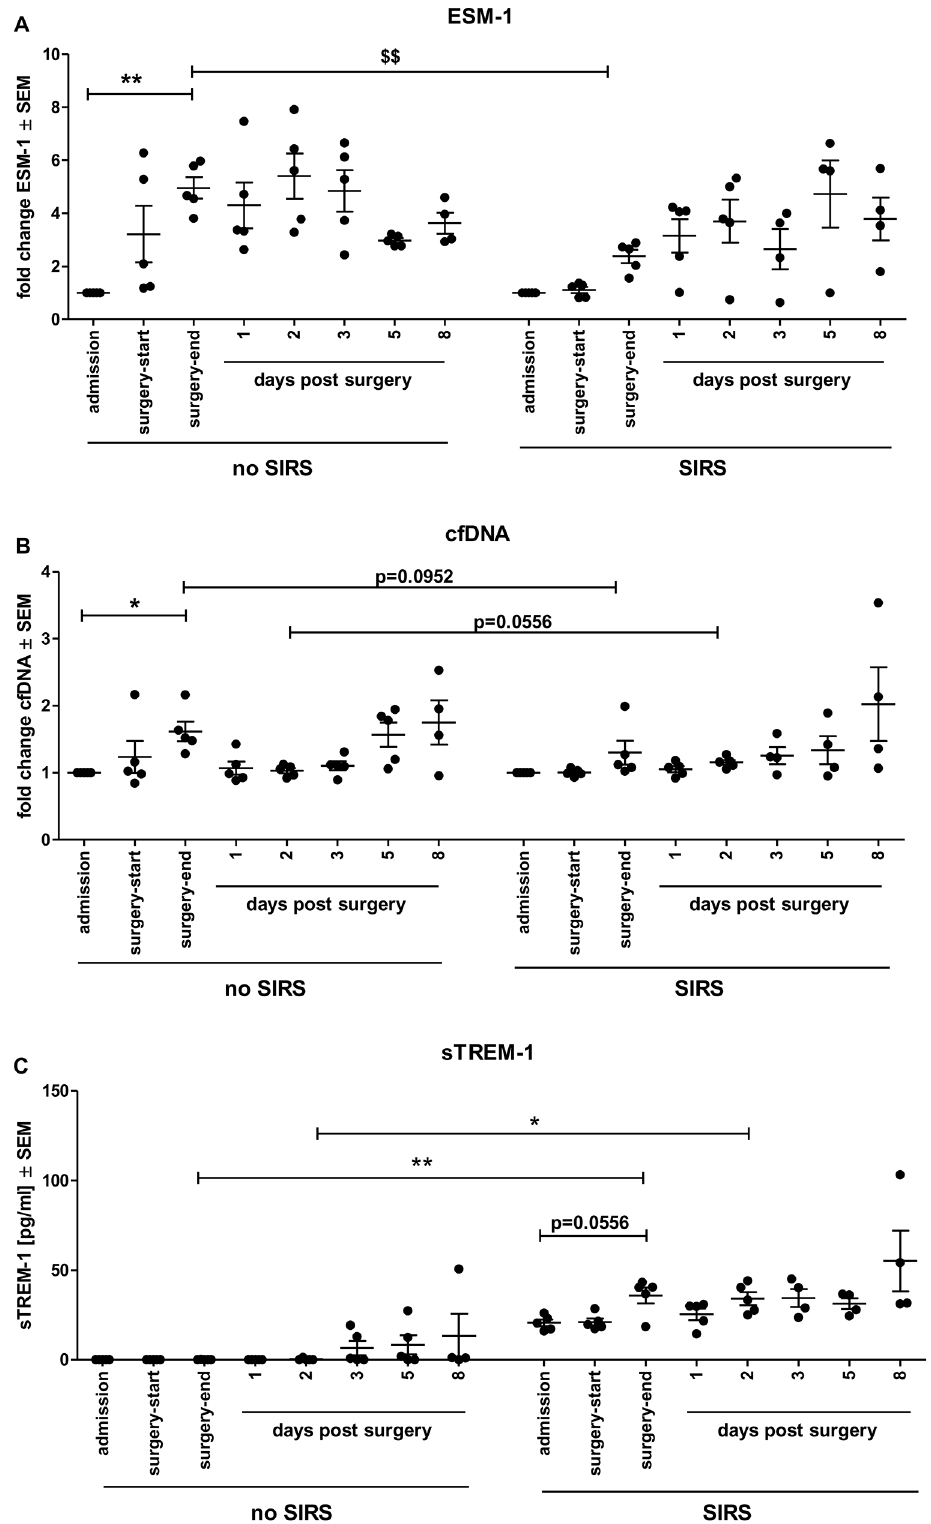
Fig 3. Normalized plasma levels of endocan and cfDNA rise significantly slower whereas soluble TREM-1 plasma levels are upregulated at early time points in SIRS patients. (A) Fold changes